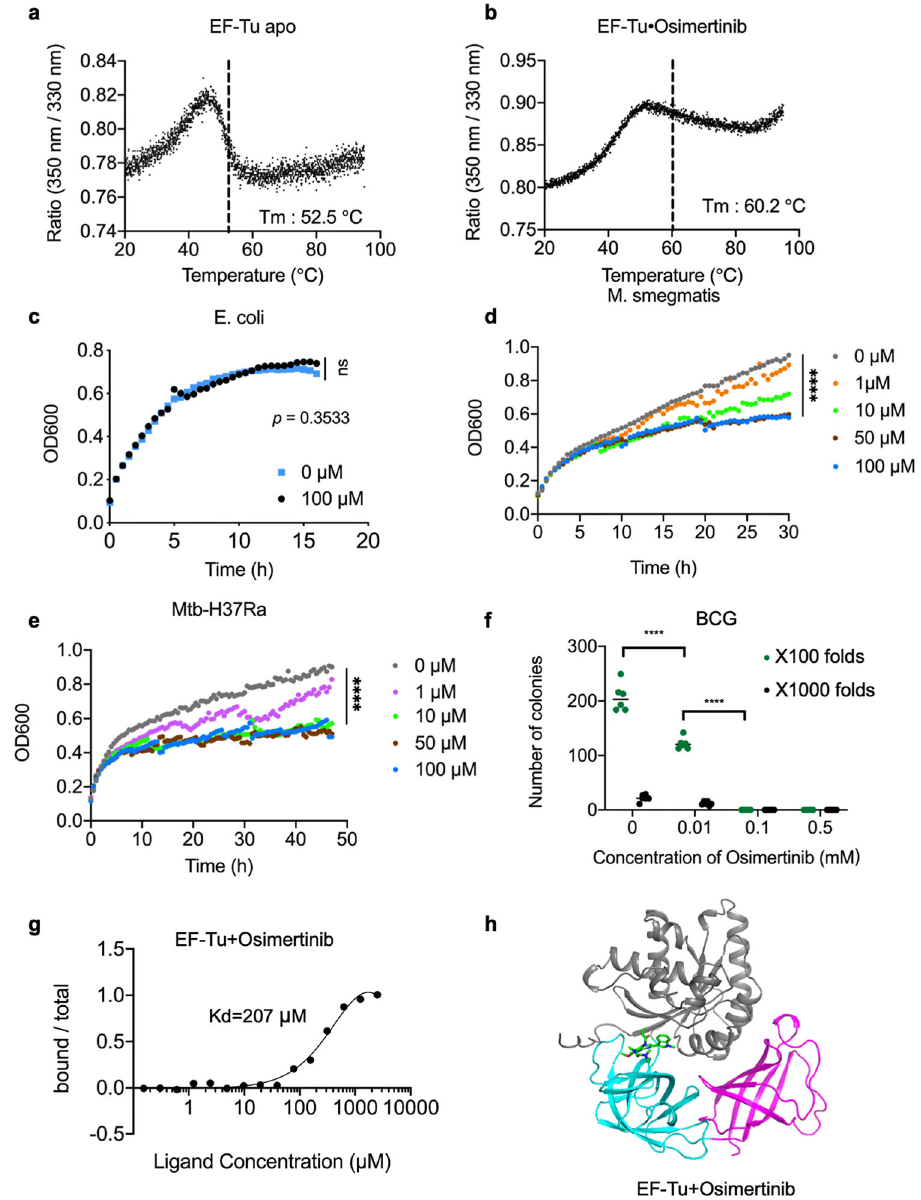
transition midpoints of EF-Tu and EF-Tu/Osimertinib were detected by the Nano-DSF method. c – f Osimertinib did not affect E. coli growth, but signi fi cantly inhibited the growth of M. smegmatis , Mtb H37Ra, and M. bovis BCG strains. Different concentrations of Osimertinib were added to the bacterial strains, and cell densities were detected at different times ( c – e ). After treatment with varying concentrations of Osimertinib, the BCG strains were diluted 100 or 1000 times, and the numbers of colonies were calculated ( f ). g The MST result showed that Osimertinib is bound with EF-Tu in vitro. h The in silico modeling structure of EF-Tu and Osimertinib complex. EF-Tu was shown in a cartoon model. Osimertinib was shown in a stick model. The error bars represented the standard deviations (SD). * P < 0.05, ** P < 0.01, ns no signi fi